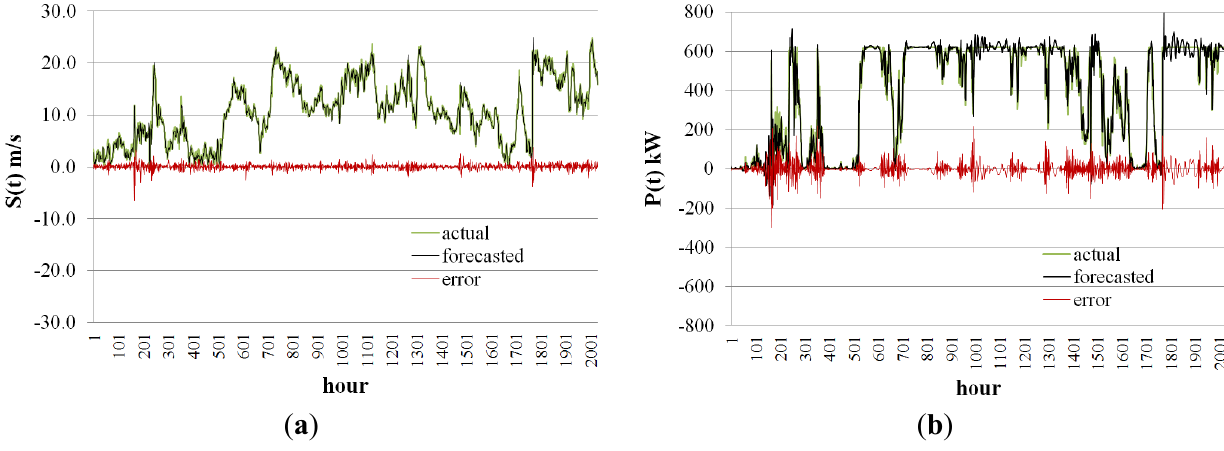
Figure 9. Actual/forecasted wind speeds/powers and errors during the autumn: ( a ) S( t ); ( b ) P( t ).